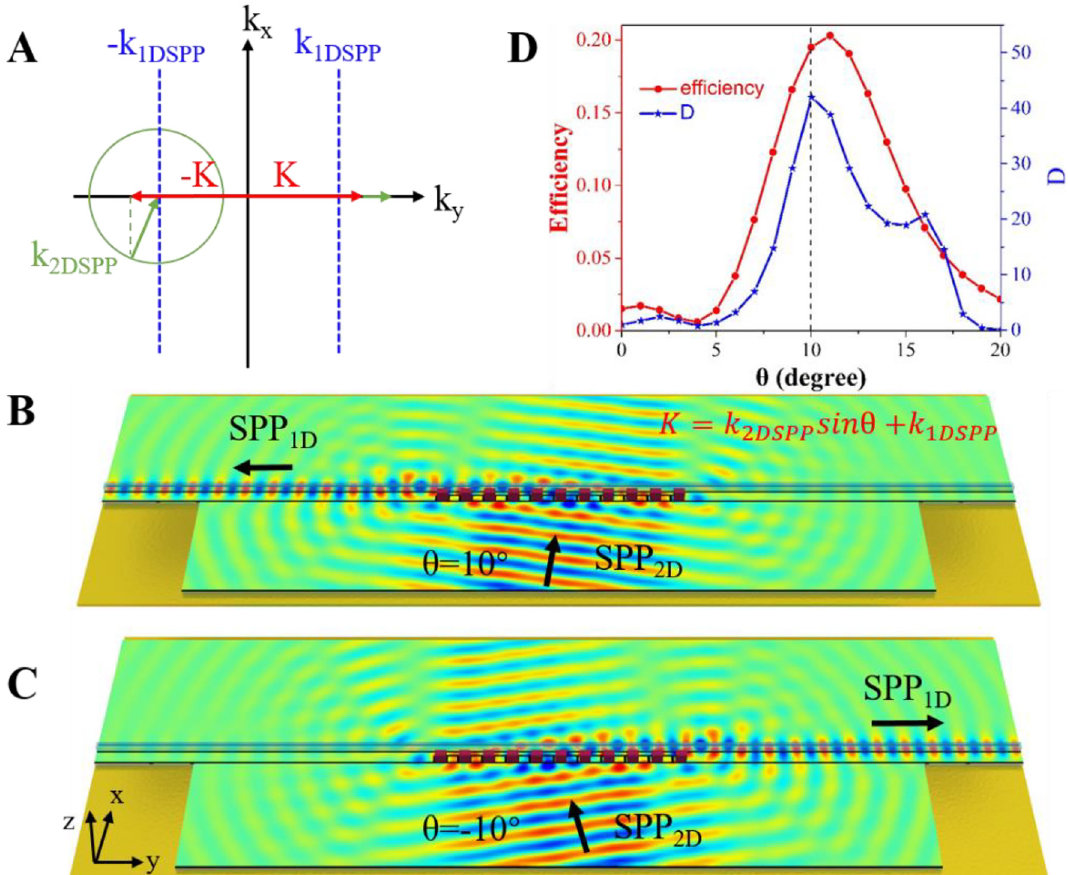
Figure4: DemonstrationofanundirectionalSPProuterbasedonthegratingmeta-wall.(A)Schematicofthemomentummismatchesbetween the inputting 2D SPP and the 1D SPP along the plasmonic waveguide compensated by the reciprocal lattice vector of the grating meta-wall. FEM-simulated near-field E z pattern on a plane above the plasmonic metal for a SPP Gaussian beam striking the grating meta-wall for the incident angle θ = 10 ° (B) and θ = − 10 ° (C) respectively under the case of the designed reciprocal lattice vector satisfying K (cid:1) k 2 DSPP sin θ + k 1 DSPP (D) The coupling ef fi ciency and directivity of this unidirectional SPP router versus the incident angle θ of 2D